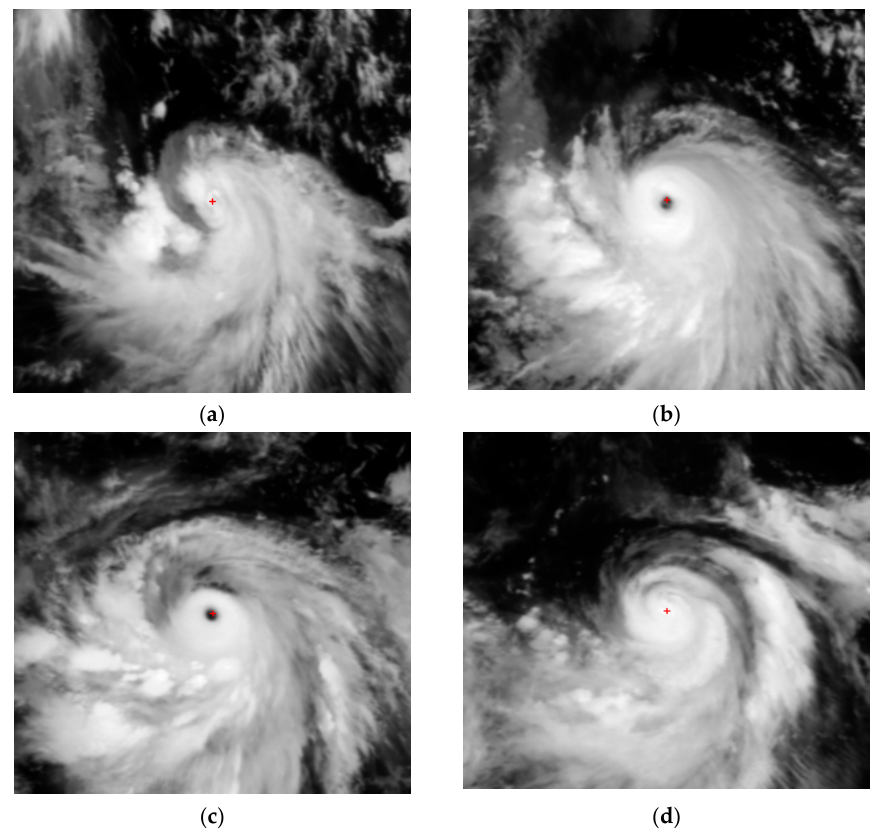
Figure 2. Center of the TC calculated using the proposed method. ( a ) IR image at 0530 UTC on 1 August 2014; ( b ) IR image at 0600 UTC on 2 August 2014; ( c ) IR image at 0000 UTC on 3 August; ( d ) IR image at 1830 UTC on 4 August.